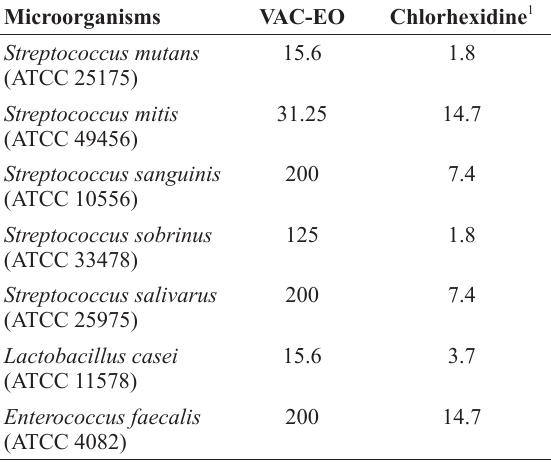
Minimum inhibitory concentration (MIC) values (μg/mL) of the essential oil of Vitex agnus castus (VAC–EO) against selected cariogenic